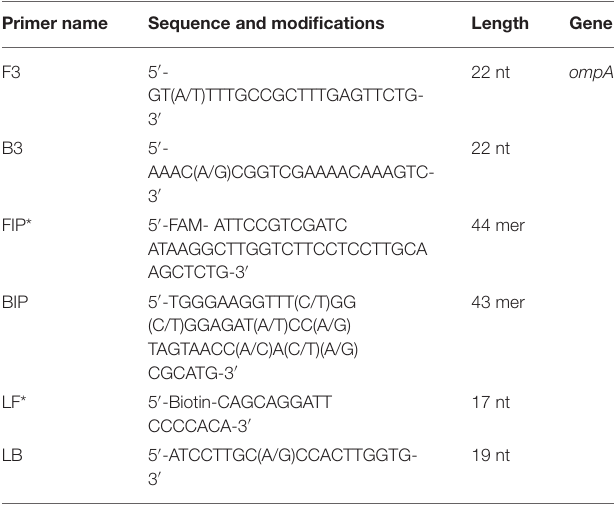
TABLE 1 | C. trachomatis -LAMP primers used in this